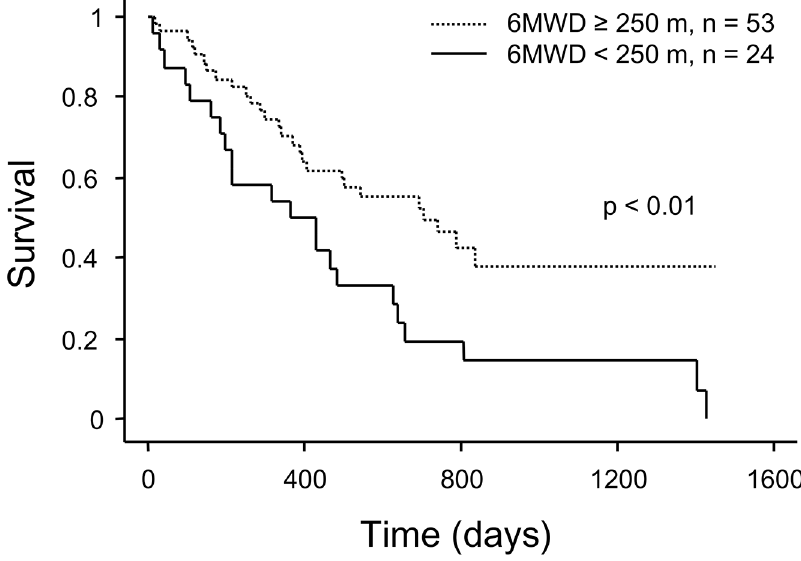
Fig 3. Kaplan − Meier survival curves for candidates with interstitial lung disease grouped based on 6MWD. p < 0.01 by log-ranktest. 6MWD, 6-min walkingdistance.